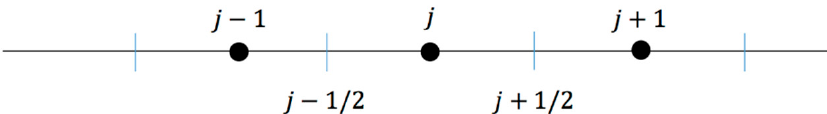
Figure A1. One-dimensional mesh.